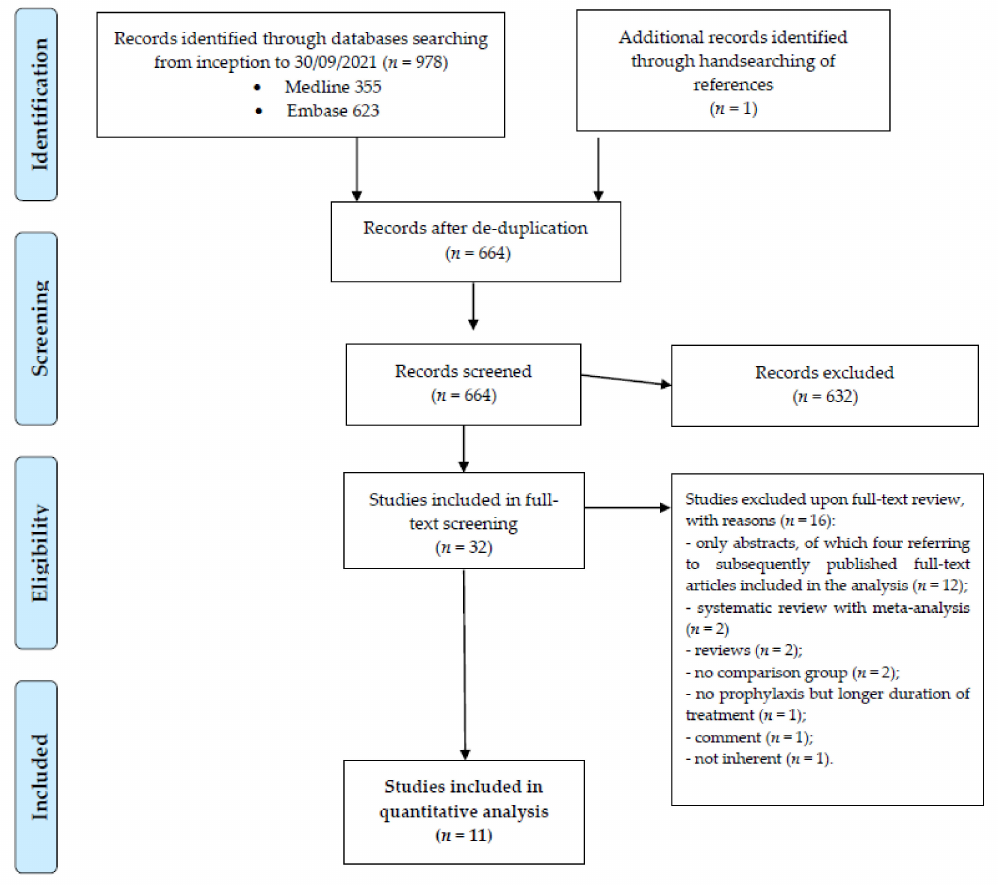
Figure 1. Results of literature search and flow diagram for selection of eligible